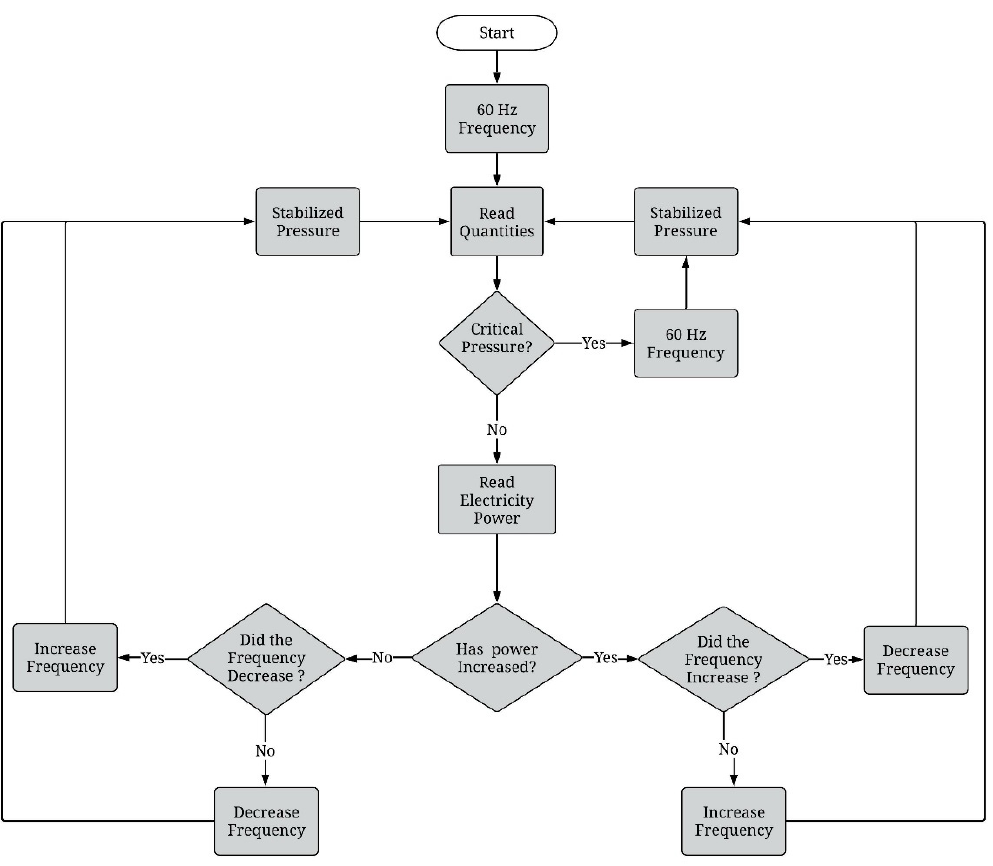
Figure 3. Flowchart of the developed logical model of control.